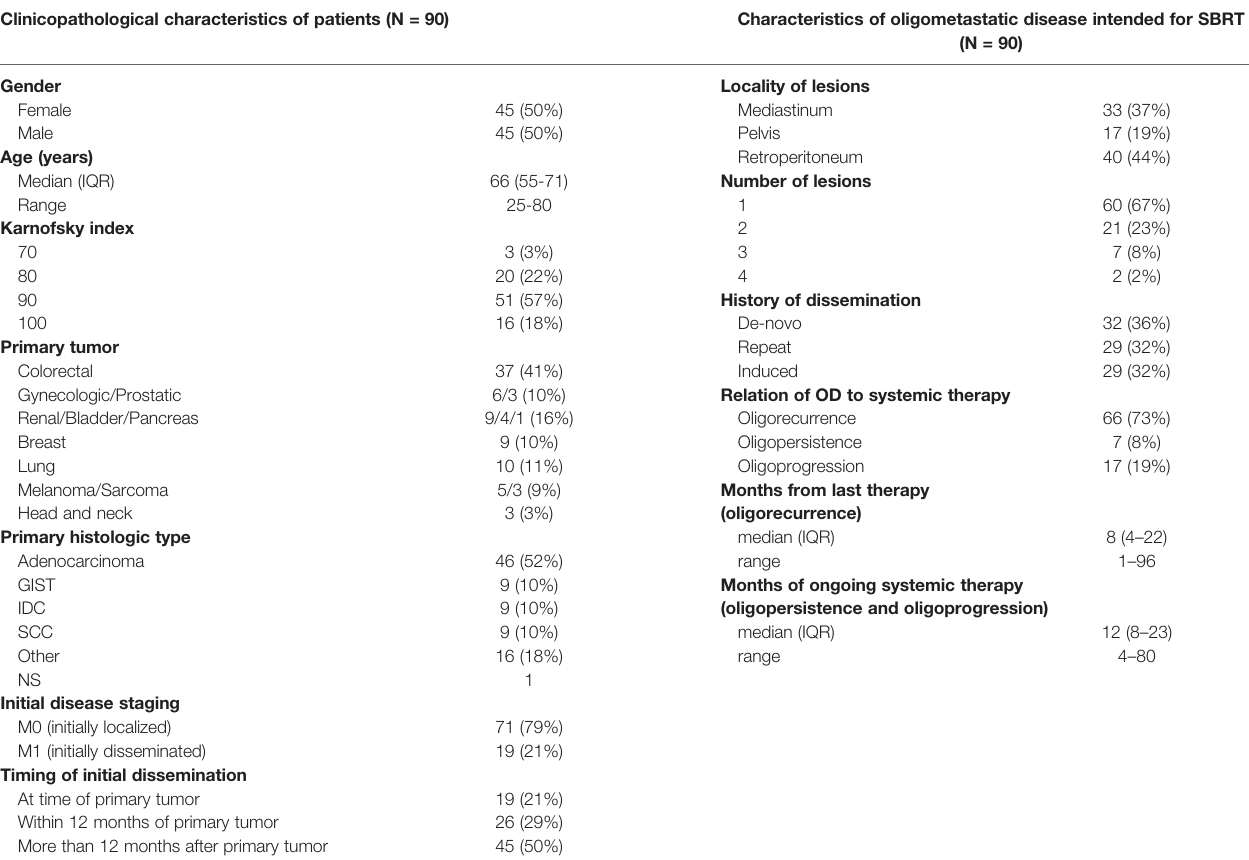
TABLE 1 | Patients ’ clinicopathological characteristics (left) and characteristics of oligometastatic disease intended for SBRT (right). Clinicopathological characteristics of patients (N = 90) Characteristics of oligometastatic disease intended for SBRT